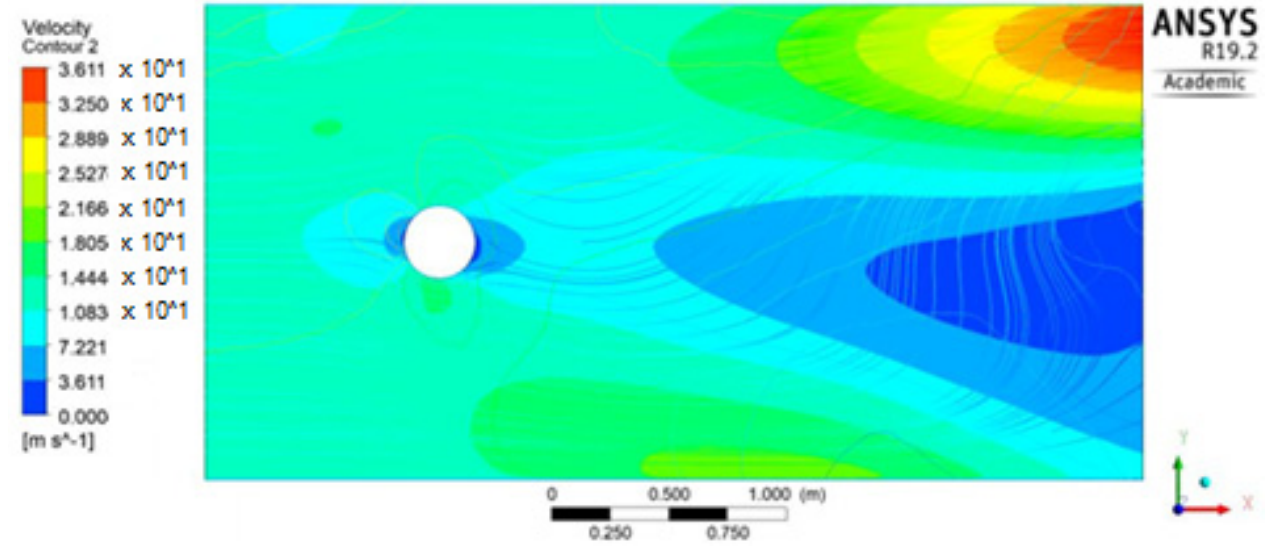
Figure 11. Illustration of flow patterns and vortex effect around a platform from CFD study in ANSYS Fluent R19.2, showing the Velocity Contour profile.